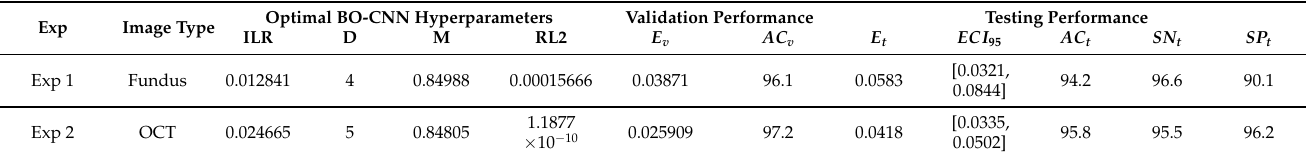
Table 12. Summary of the results obtained for the optimal BO-CNNs of Experiment 1 and 2. The network section depth is denoted as ‘D’ and experiment is abbreviated as ‘Exp’. The accuracy, sensitivity, and specificity are expressed as